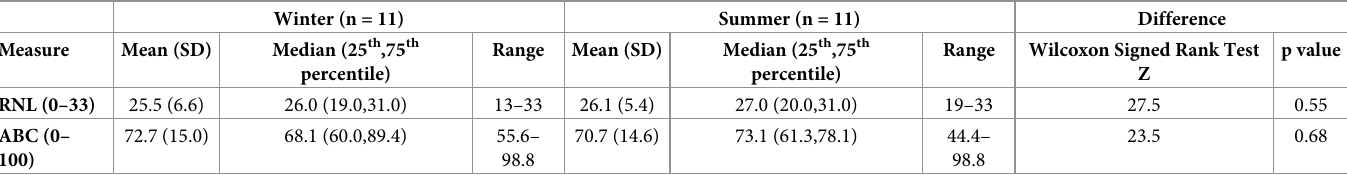
Table 4. Self-perceived outcomes by season.